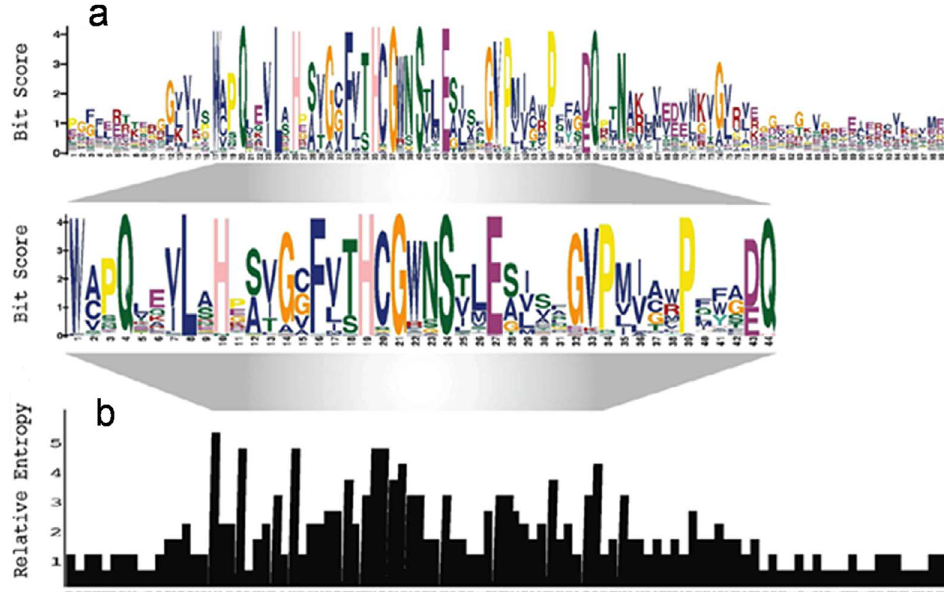
Figure 1. Gene identification by PSWM. Conservation [Bit score (a) and Relative entropy (b)] of the PSPG motif of 89 UGTs from various plant sources.